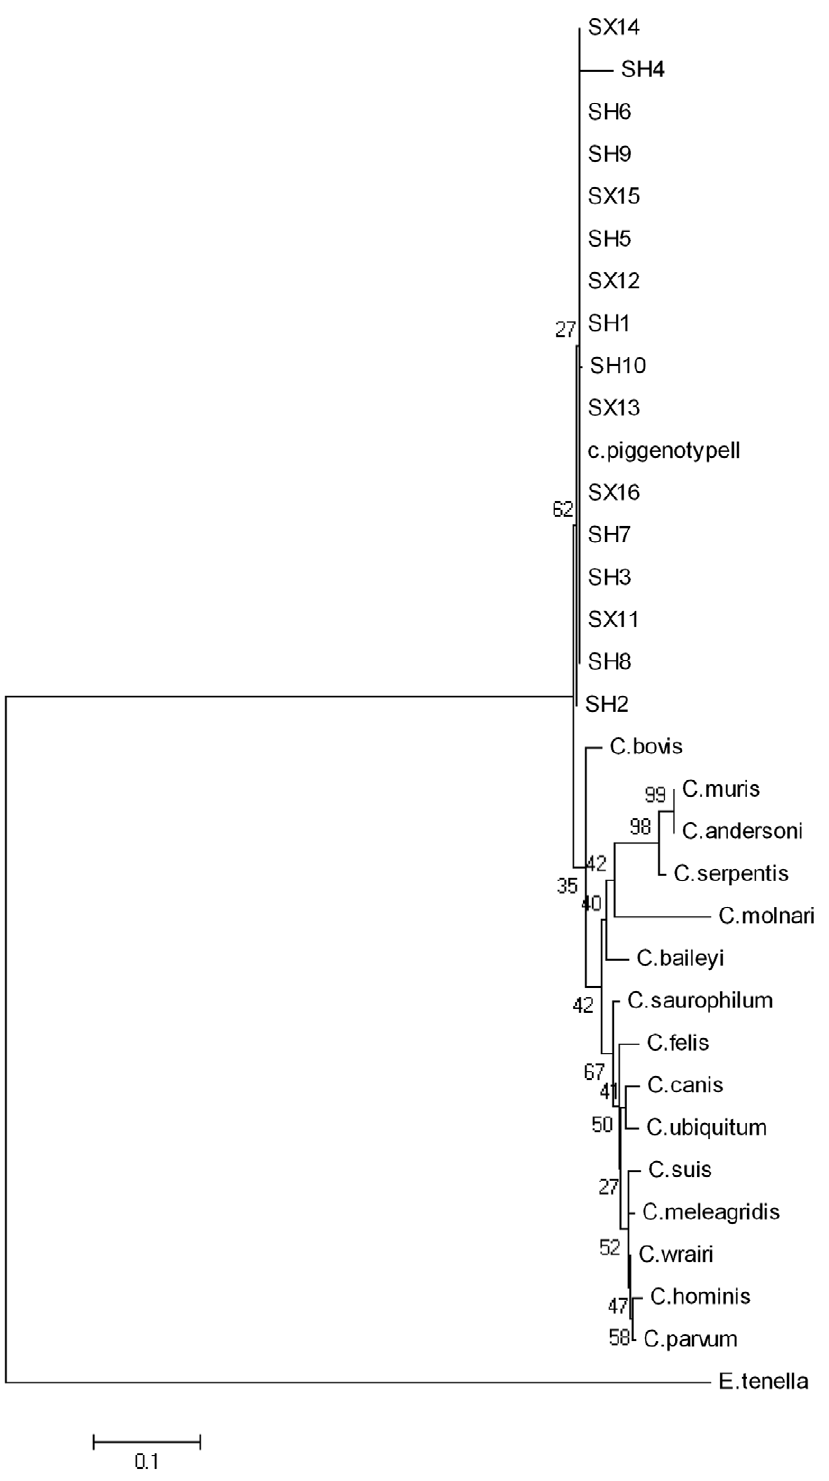
Figure 3. Phylogenetic analysis. 18S rRNA sequences from the respective Cryptosporidium isolates identified were compared phylogenetically using the MEGA 4.1 software. The phylogenetic tree obtained demonstrates the genetic diversity of the Cryptosporidium genotype II isolates identified from stool samples from Shanghai (SH1–10) and Shaoxing (SX11–16). Analysis was based on the nested-PCR of the18S rRNA locus sequence using the tree method of Neighbor Joining.